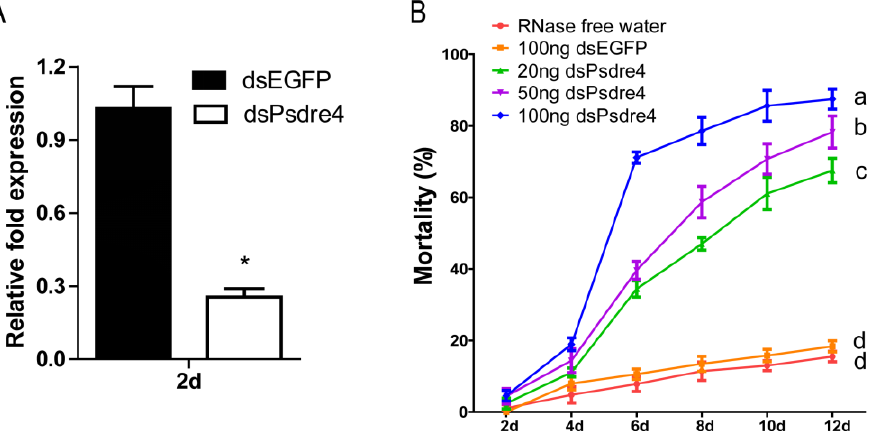
Figure 3. Effects of silencing Psdre4 on P. striolata adults by injection. ( A ). Relative expression levels of Psdre4 in 2-day beetles after injection of 100 ng dsEGFP or dsPsdre4. Data are plotted as mean ± SEM. Statistical analysis was evaluated using Student’s t -test (* p < 0.05). ( B ). Percentage mortality of beetles following dsPsdre4 injection. Data are plotted as mean ± SEM. Statistical analysis of percentage mortality on day 12 was determined by using one-way ANOVA followed by Duncan’s multiple-range test. Different letters mean significant differences at p < 0.05.